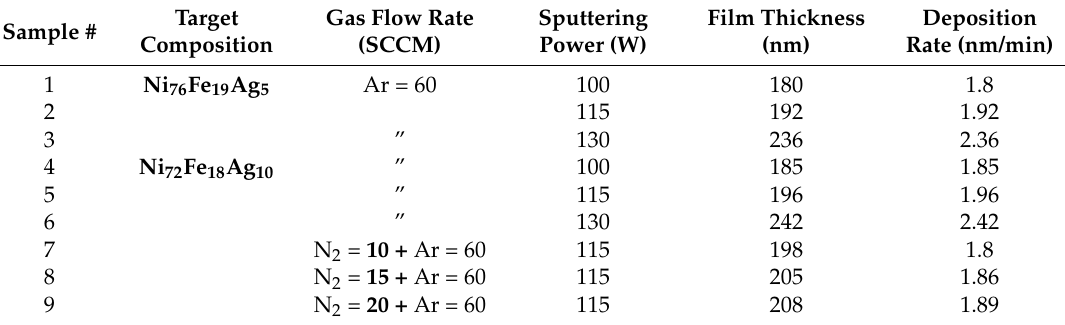
Table 1. Thin film deposition processing parameters for two different target